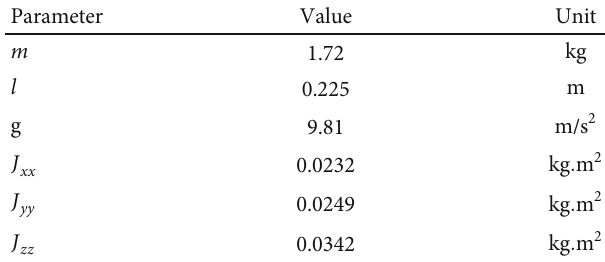
Table 1: Physical parameters of the quadrotor